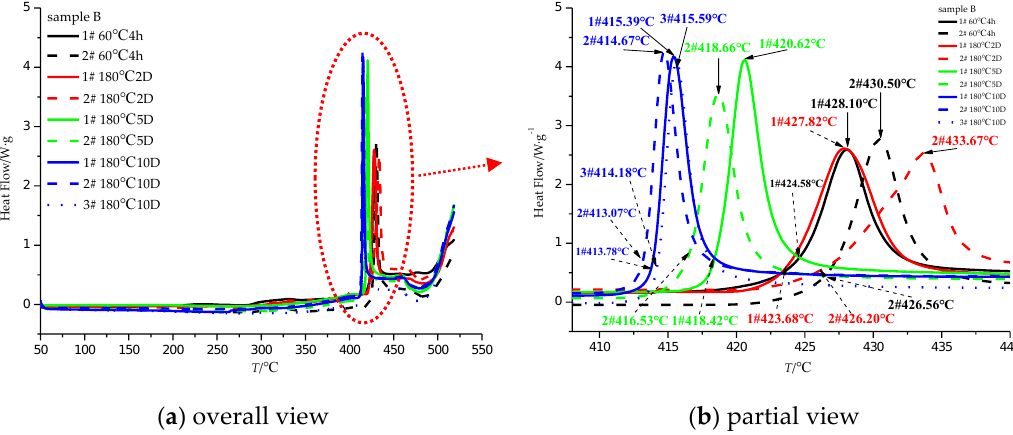
Figure 8. DSC curves of sample B after exposure to 60 °C for 4 h and 180 °C for 2 – 10 days.